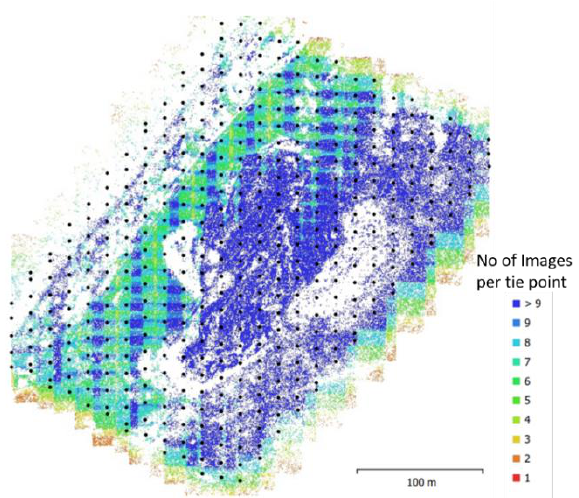
Figure 5. Image overlap for 423 DJI P1 images with 507,580 tie points as estimated in Metashape (see Table